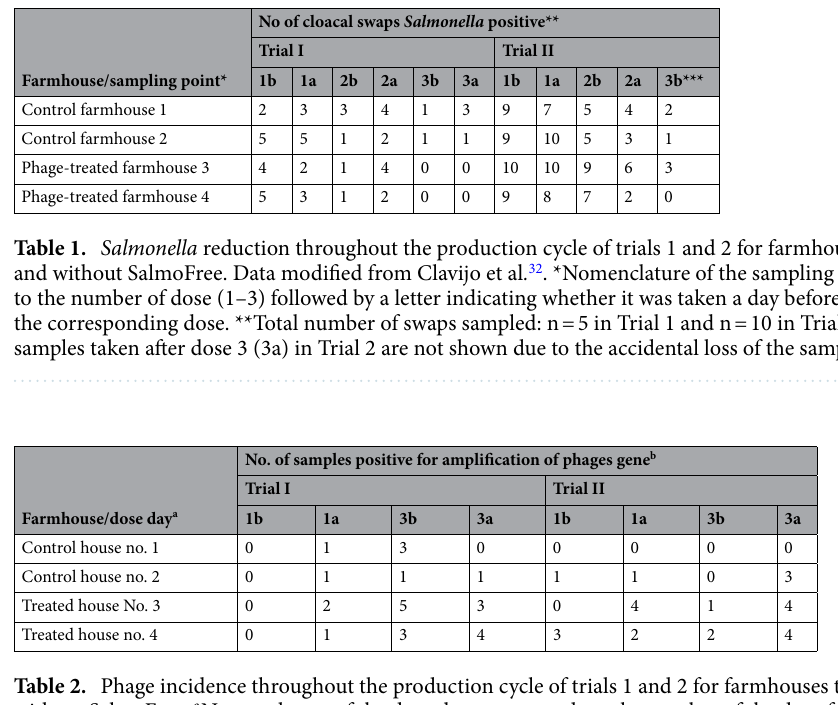
Table 2. Phage incidence throughout the production cycle of trials 1 and 2 for farmhouses treated with and without SalmoFree. a Nomenclature of the dose day corresponds to the number of the dose followed by a letter indicating whether it was taken a day before (b) or after (a) the corresponding dose. b No. of positive samples for amplification of the phage tail fiber protein gene of phages from the total samples where total sample size per time point is 5.